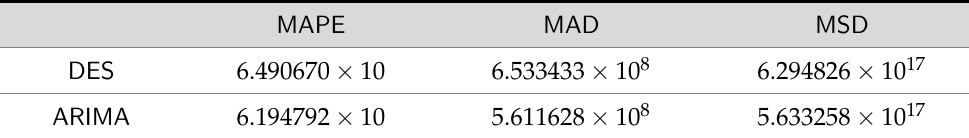
Figure 9. ARIMA forecast based on (AIC), (BIC) and the Jarque-Bera normality test. Table 2. Error table for ARIMA and DES models using MAPE , MAD and MSD metrics (see Section